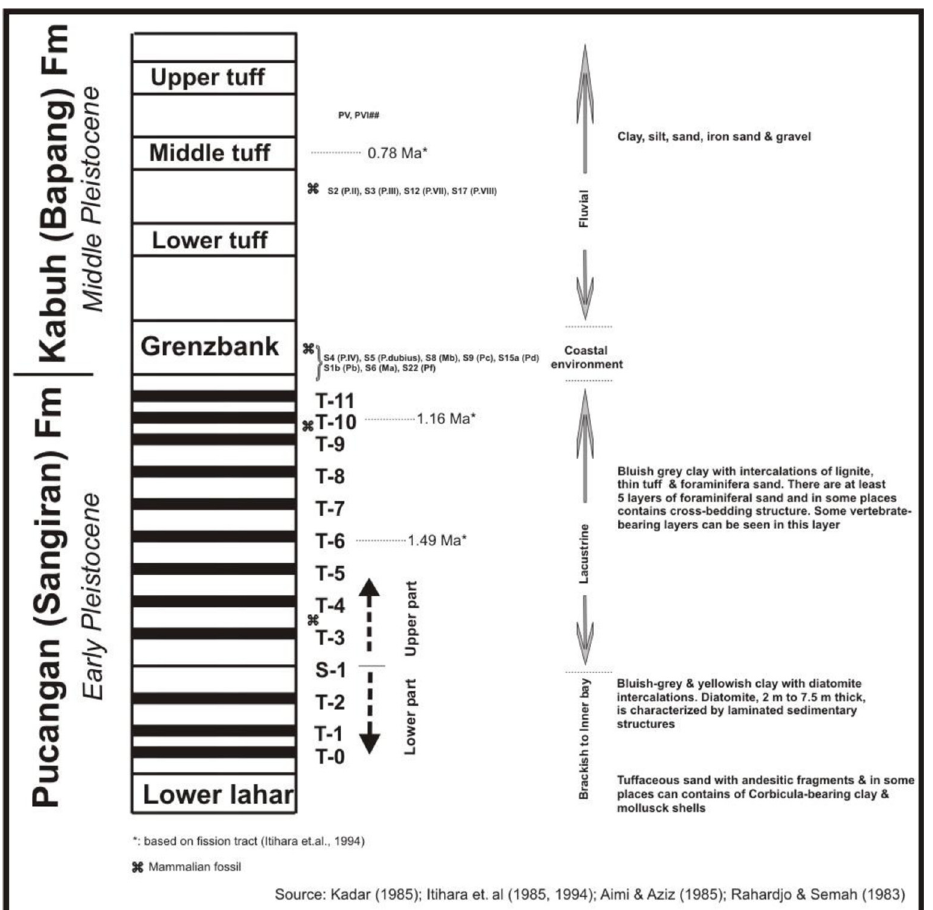
Figure 3. Pucangan and Kabuh Formations in the Sangiran area [7, 8, 15,